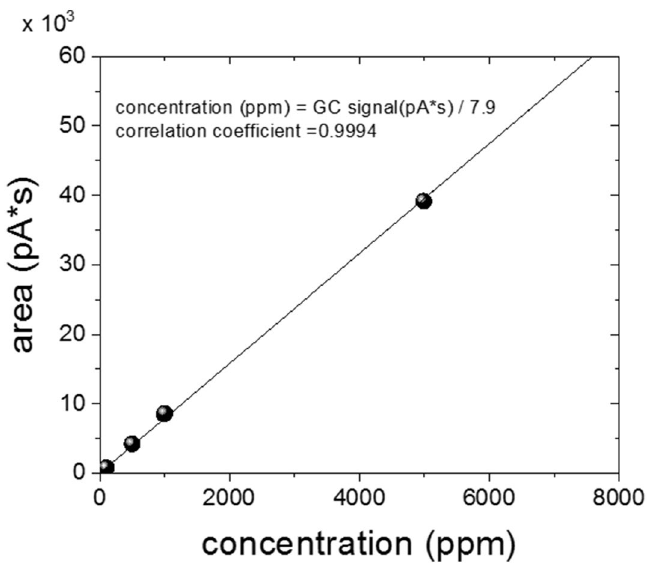
Figure 4. Calibration curve obtained for standard hydrogen gases with hydrogen concentrations of 100 ppm, 500 ppm, 1000 ppm, and 4989 ppm with helium gas as the balance. (correlation coefficient: